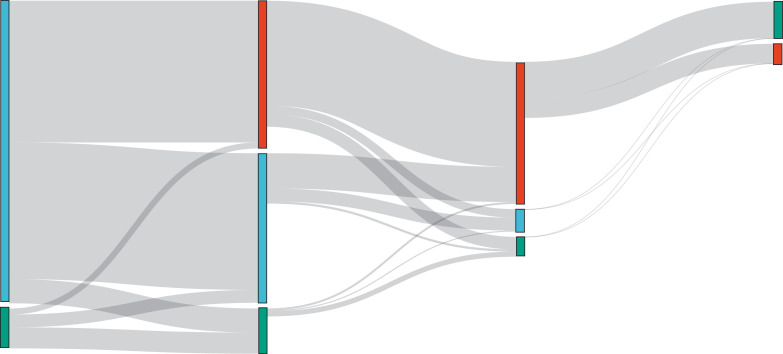
Sankey diagram indicating the number of male scientists by archetype at each career stage and transitions from one stage to the next, including changes on researchers’ archetypes.Red refers to the Leader archetype, Blue refers to the Specialized archetype and Green refers to the Supporting archetype. .